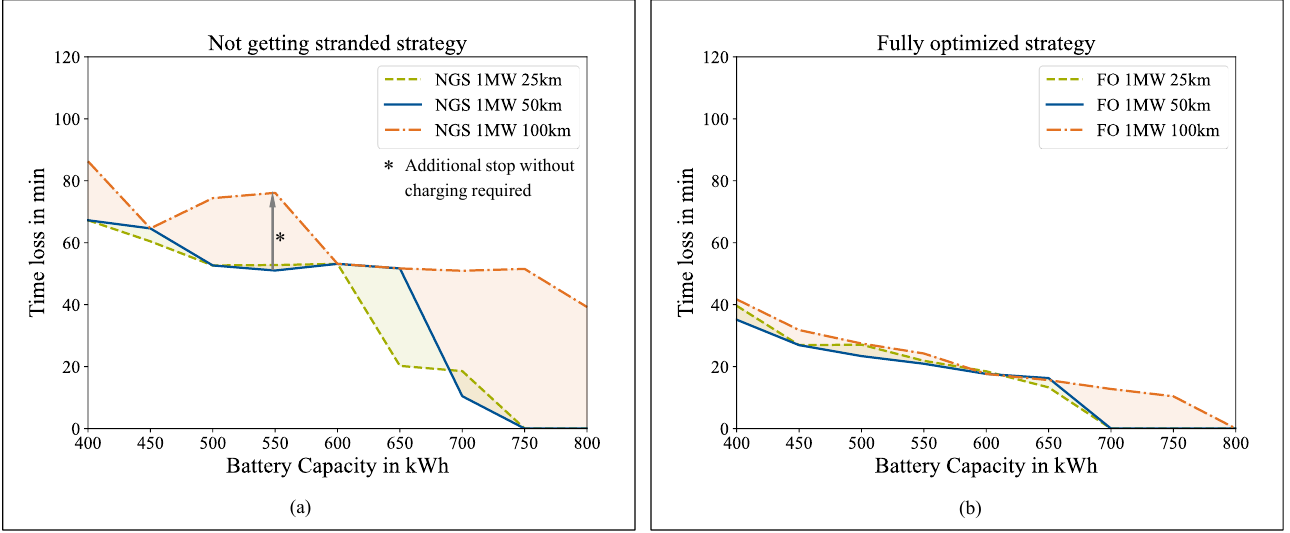
Figure 7. Influence of infrastructure resolution (distance between two charging sites) on absolute time loss using ( a ) the NGS strategy and ( b ) FO strategy. In contrast to NGS, the FO strategy can compensate for a sparse infrastructure resolution for most battery capacities.